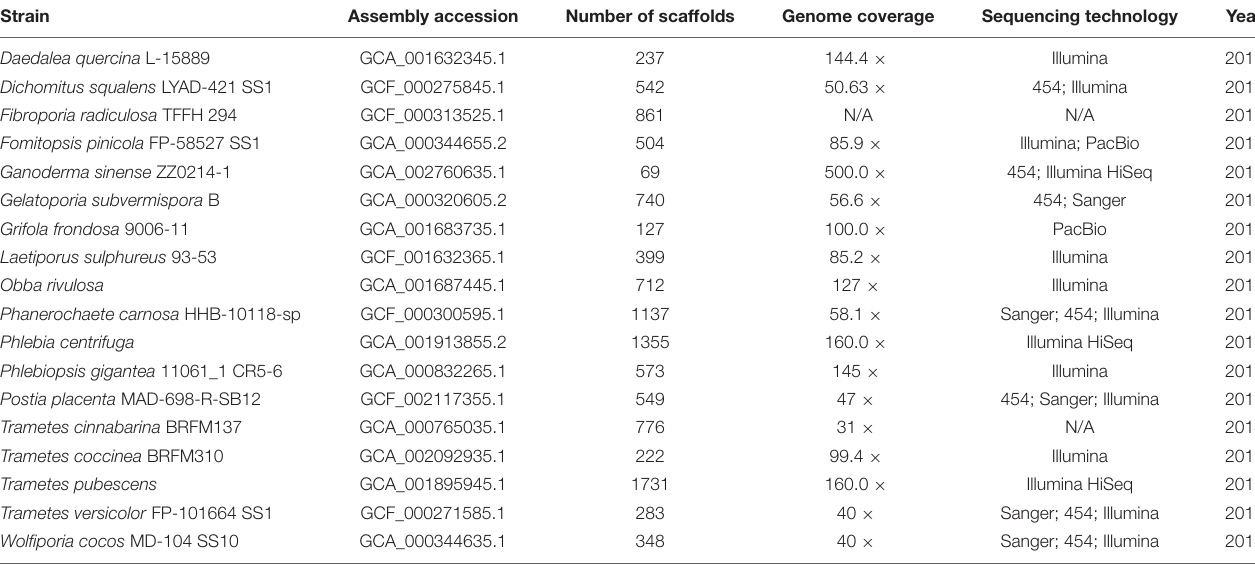
TABLE 1 | Representative genomes of order